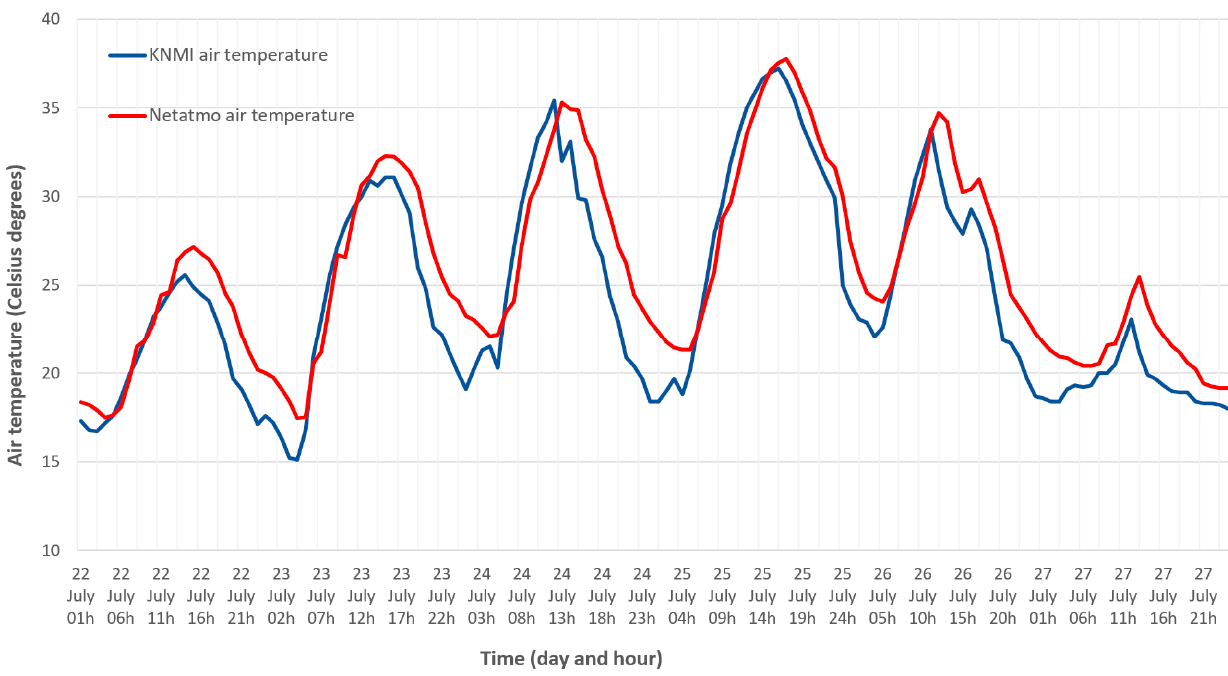
Figure 4. Comparing official KNMI recordings with interpolated temperature values from surfaces generated from Netatmo recordings.